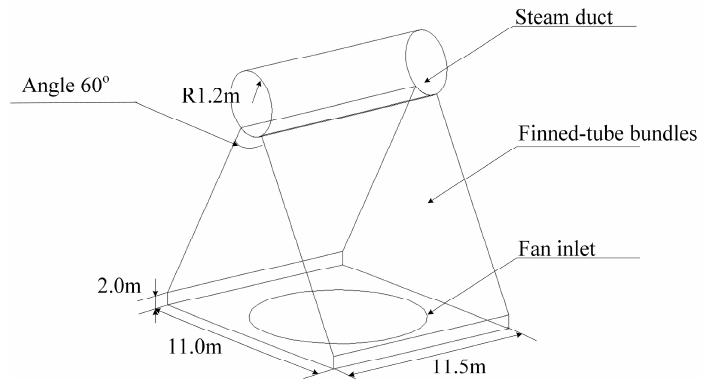
Figure 2. The side view of the DACC.